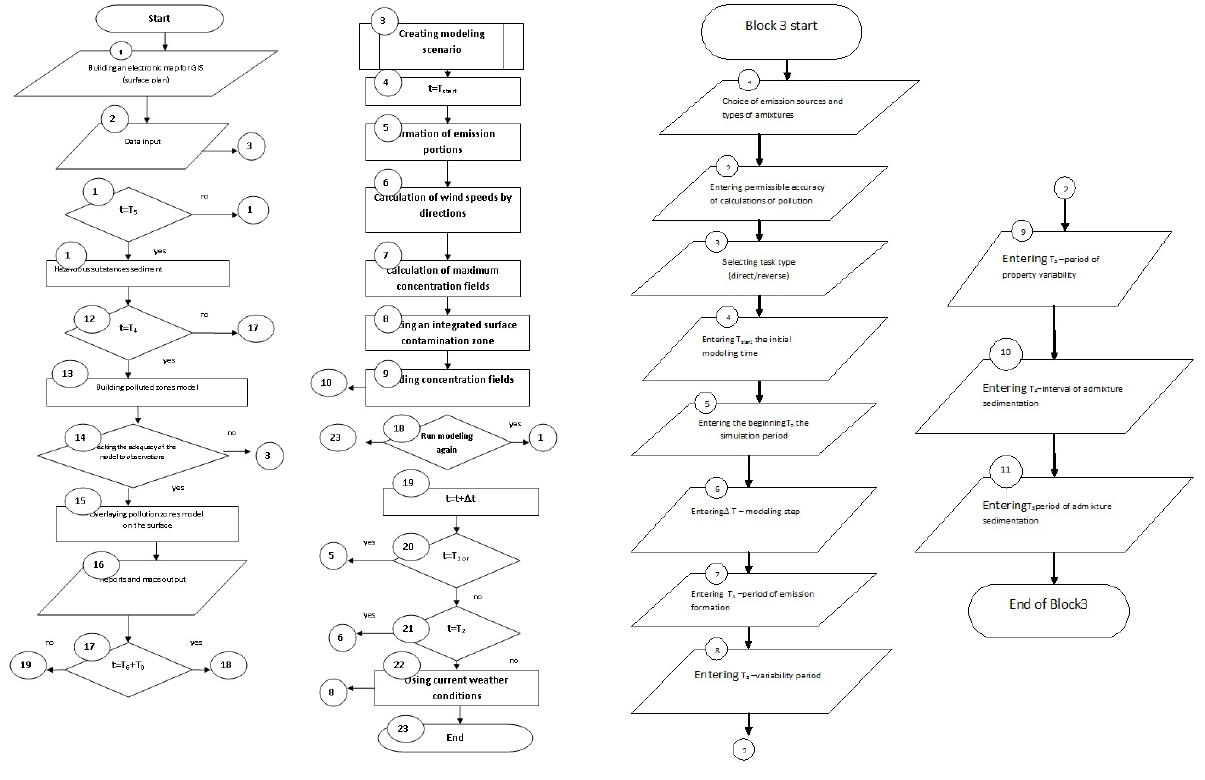
Figure 3: Structure of the block 3 “Creating a simulation